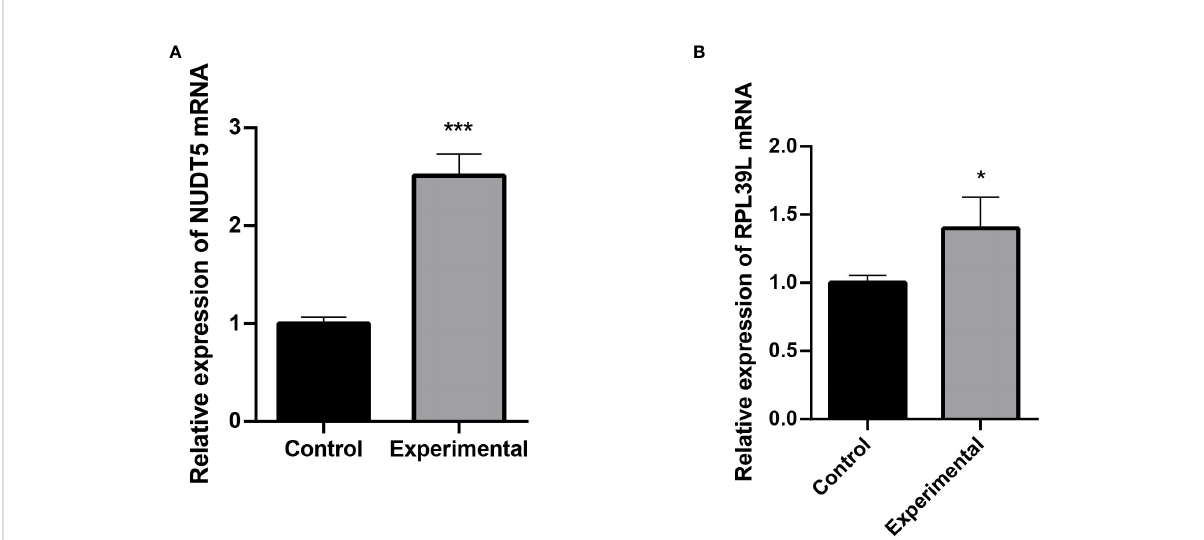
FIGURE 6 Detection of RPL39L and NUDT5 expression using qRT-PCR. (A) Relative expression of NUDT5 mRNA. (B) Relative expression of RPL39L mRNA. *** indicates P<0.001 compared with the control group; * indicates P<0.05 compared with the control